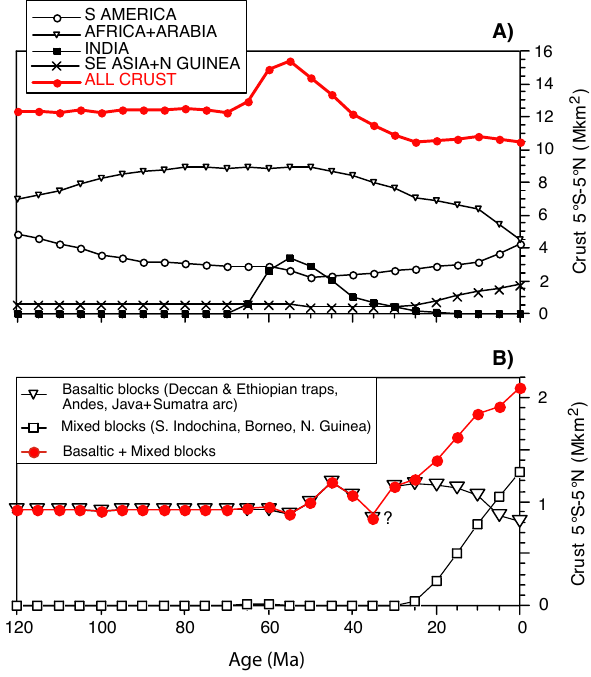
Fig. 6. (A) Estimates of land area within equatorial humid belt (5 ◦ S–5 ◦ N) as a function of time since 120Ma obtained by apply- ing the composite APWP (Table 1; Fig. 2) and finite rotation poles of Besse and Courtillot (2002) for major continental blocks and the rotation poles of Replumaz and Tapponnier (2003) for SE Asian blocks as discussed in text. (B) Estimates of key (most weatherable in the most favorable environment) land areas comprised of vol- canic arc provinces (Java, Sumatra, Andes), large basaltic provinces (Deccan Traps, Ethiopian Traps), and mixed igneous-metamorphic provinces (South Indochina, Borneo, New Guinea) in the equato- rial humid belt (5 ◦ S–5 ◦ N) as a function of time from 120Ma to present. The rest of the world’s continental regions in the equato- rial humid belt are generally characterized by low elevation (Ama- zon and Congo basins), hence weathering tends to be low and